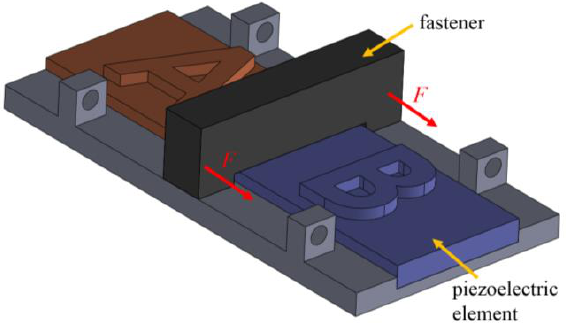
Figure 2. Schematics of a micro-positioning actuator with a piezoelectric element, a fastener, and two electrodes.